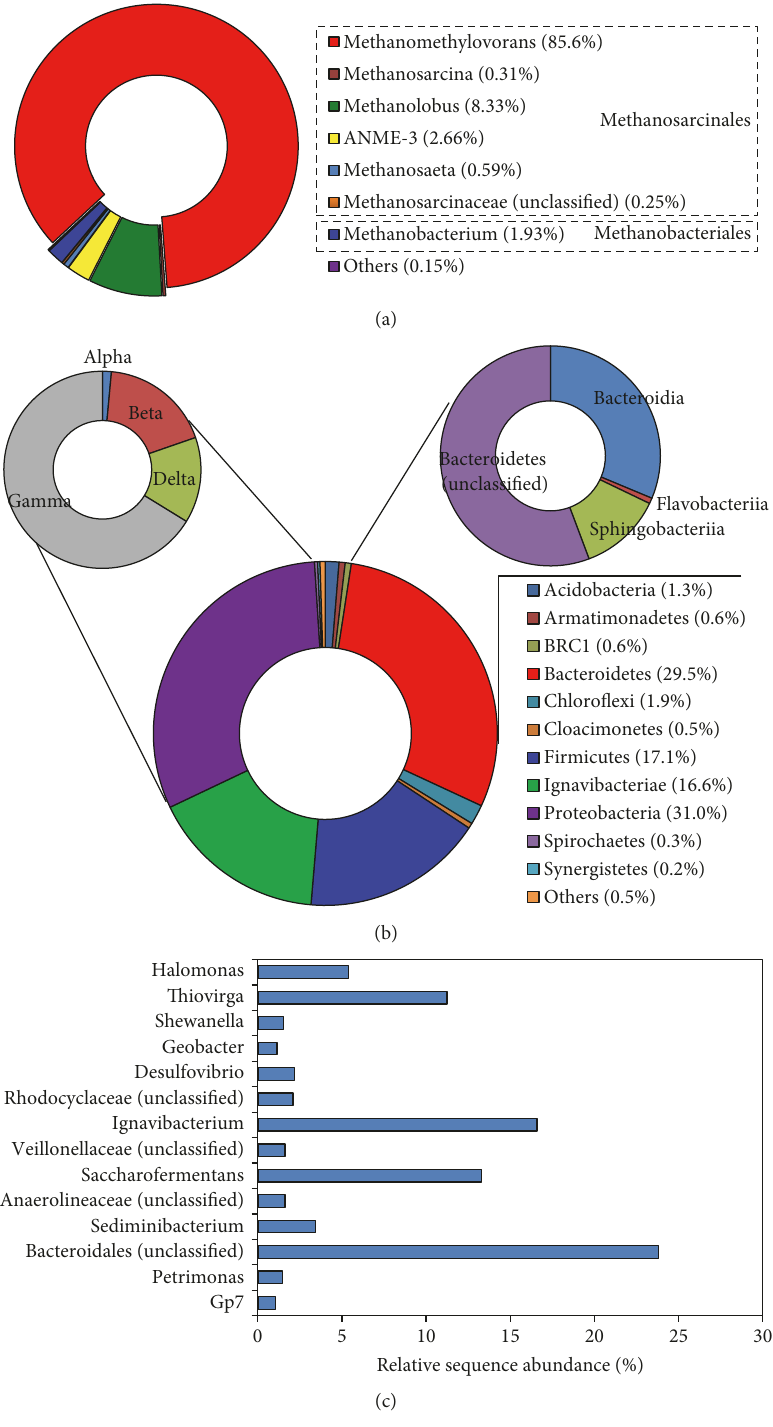
Figure 1: High-throughput sequencing analysis of archaeal and bacterial 16S rRNA sequences of sludge samples taken from a tetramethylammonium-degrading CMSS reactor. (a) Phylogenetic distribution of the detected archaeal populations. “ Others ” included the low abundant populations, namely, Methanolinea (0.01%), Methanospirillum (0.01%), Methanobacteriaceae (unclassi fi ed) (0.04%), and Thermoplasmata (0.09%). (b) Phylogenetic distribution of the detected bacterial populations at the phylum and class levels. “ Others ” included 10 bacterial phylum taxa with each abundance < 0.05%. (c) Distribution of bacterial genera with relative sequence abundance >